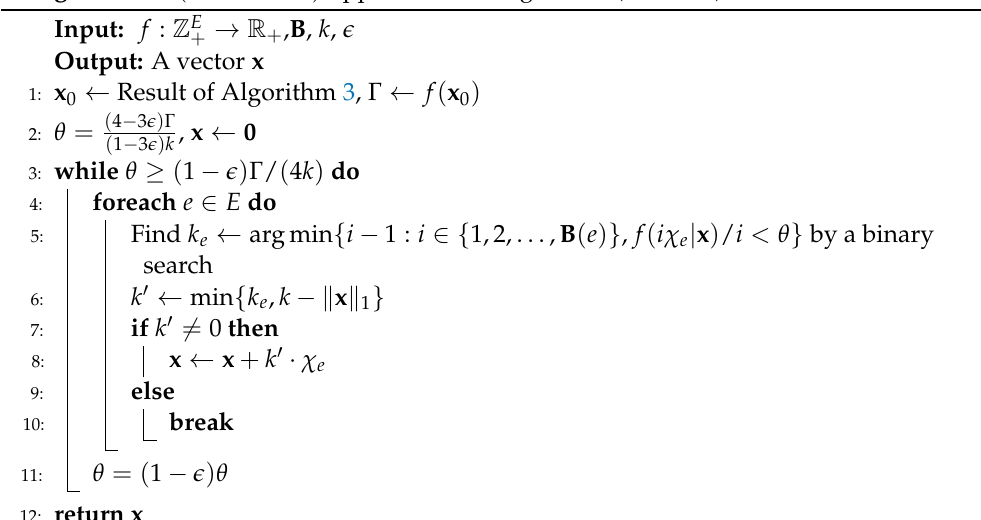
Algorithm 4: ( 1 − 1/ e − (cid:101) ) -approximation algorithm ( StrDRS2